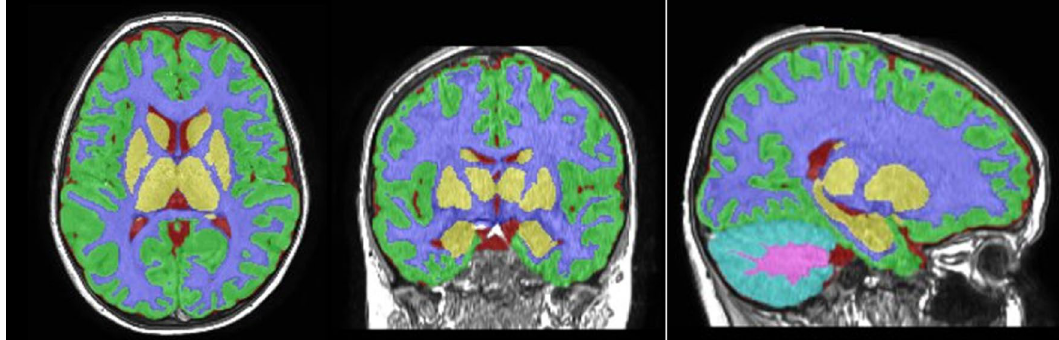
Fig. 1 Selected axial, coronal and sagittal images show color‑coded segmentation of different structures of the brain. Cortical grey matter: display in green. Deep grey matter: display in yellow. White matter: display in purple. Cerebrospinal fluid: displayed in red. Cerebellar gray matter: display in blue. Cerebellar white matter: displayed in pink